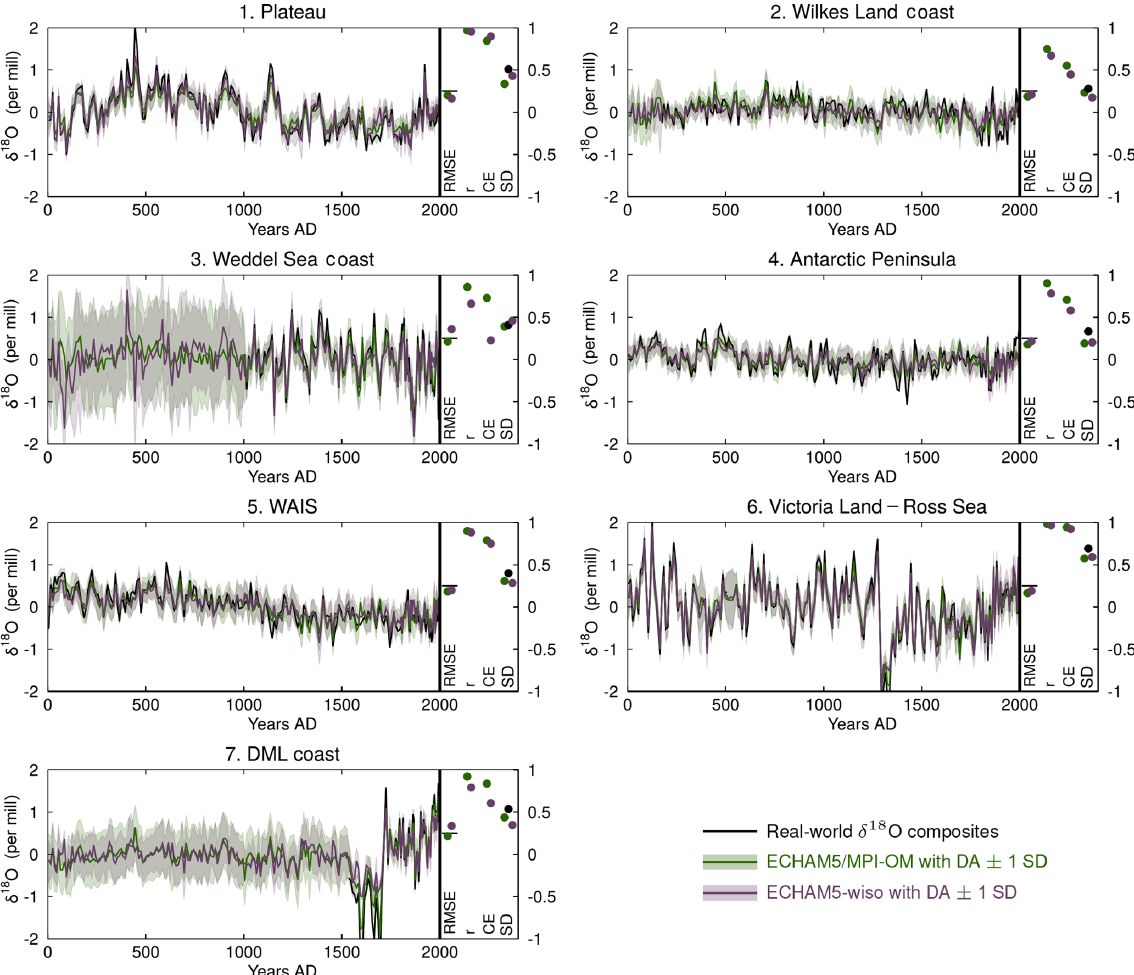
Figure 7. Changes in δ 18 O in precipitation over the 0–2000CE period in the data assimilated (Stenni et al., 2017, in black), and in the data assimilation-based reconstructions using the ECHAM5/MPI-OM (in green) and ECHAM5-wiso (in violet) models. The results are 10-year averaged over the 800–1800CE period and 5-year averaged over the 1800–2000CE period. All series are anomalies using the whole period as a reference. The uncertainty of the reconstructions is shown using colored shading ( ± 1 standard deviation of the model particles scaled by their weight around the mean). Diagnostics related to the skill of the reconstructions are displayed on the right of each panel: the RMSE between the reconstructions and the data assimilated (rmse, in per mill) along with the data error (the horizontal black lines), the correlation coefficients between the reconstructions and the data assimilated ( r ), the coefficient of efficiency of the reconstructions (CE), and the standard deviation of the data and the reconstructions over the period covered by the data